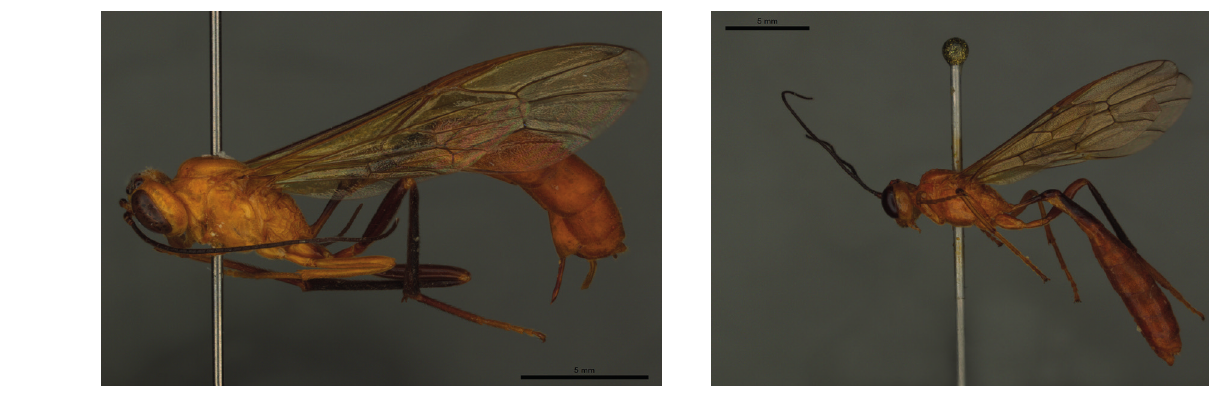
Figure 4 - Castrosion renei gauld & Bradshaw, 1997, male